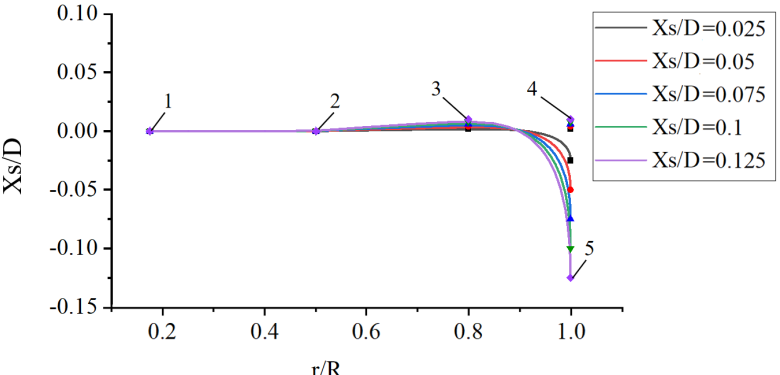
Figure 2. Rake radial distribution curves within the polygon composed of B-spline control points ( X S : rake at designated radius, D : diameter of propeller, and R : radius of propeller).